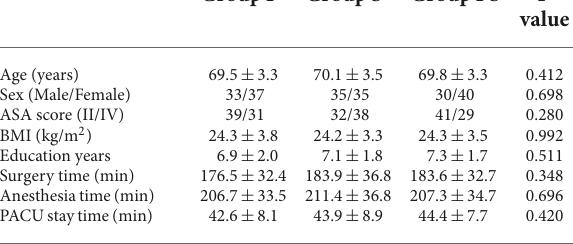
TABLE 1 Characteristics of the patients, surgery, and anesthesia. GroupP GroupS